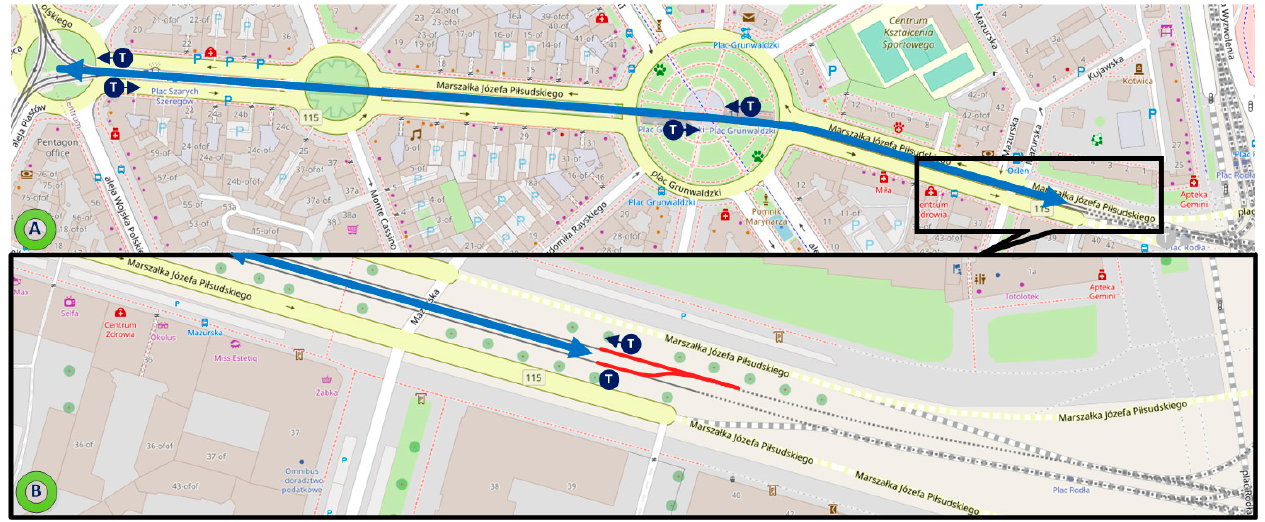
Figure 15. Using the bi-directional tram to serve the passenger traffic on the tram routes being upgraded in Szczecin (own study based on openstreetmap.org).